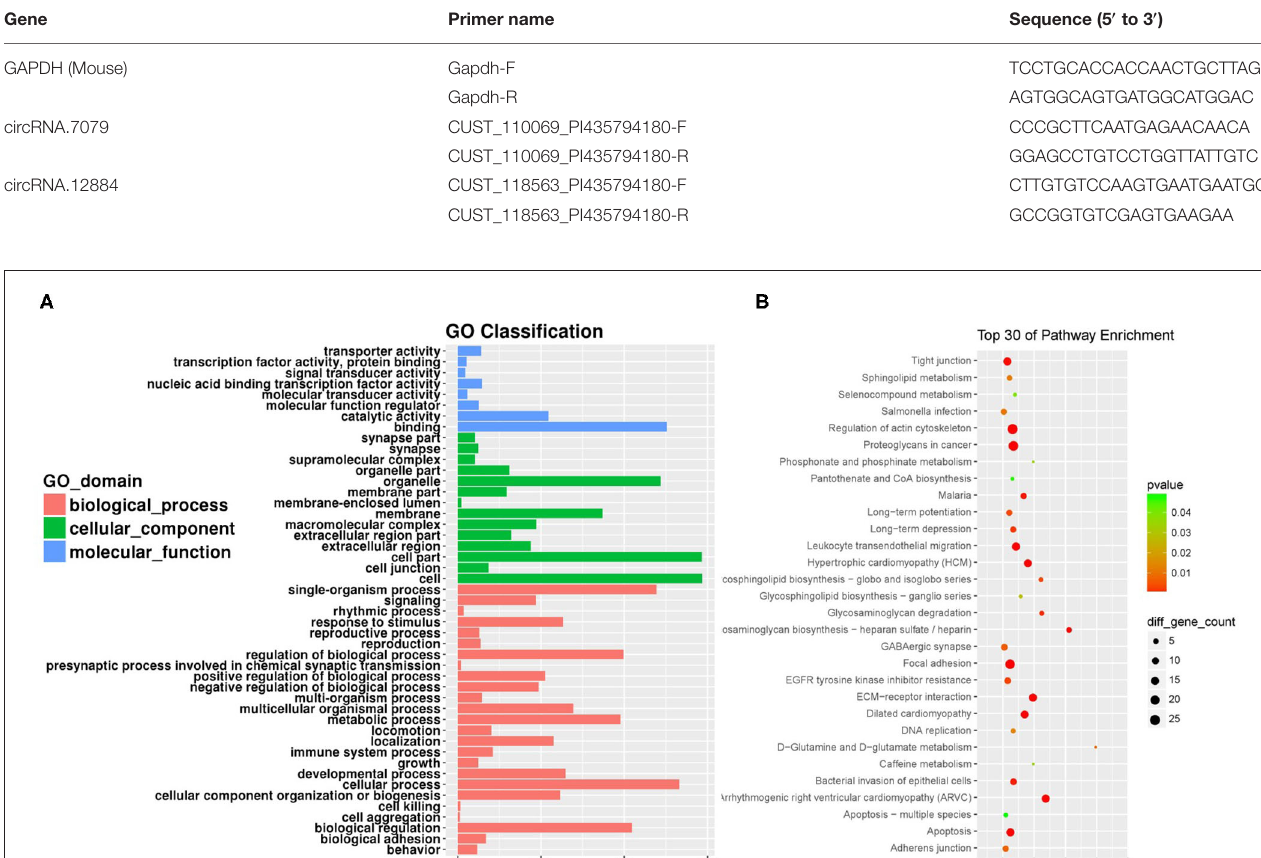
TABLE 2 | Primers used for qRT-PCR of CircRNAs after spinal cord injury (SCI).